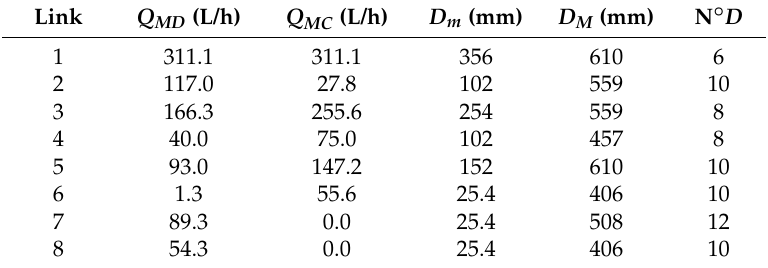
Table 2. Flow range, maximum and minimum diameters and number of possible diameters for each link obtained from the Quadratic Programming Problems QPPs for the Alperovits and Shamir network.